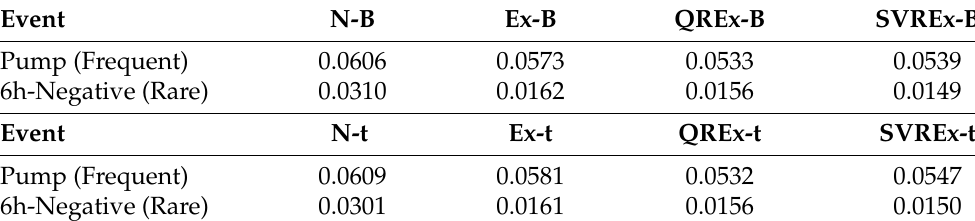
Table 5. Event-based Evaluation: Quadratic Probability